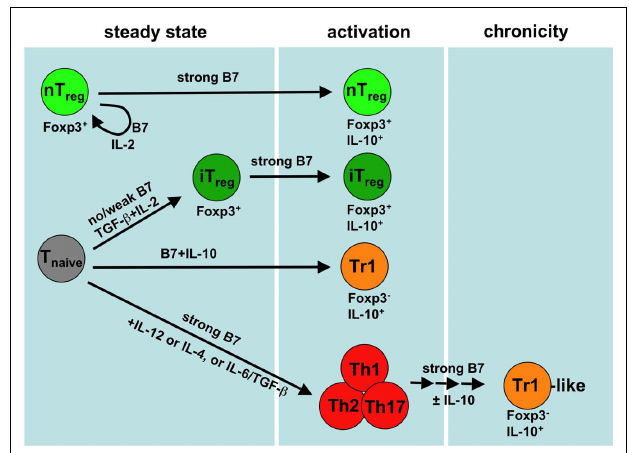
FIGURE 1 | Generation and maintenance of differentTreg subsets and their costimulation requirements. During the steady state thymus derived Foxp3 + nTregs require IL-2 and B7 (CD80/CD86) costimulation to persist.The conversion of iTregs from naiveT cells into the Foxp3 + subtype prefers the absence of B7 molecules but requires the presence ofTGF- β and IL-2. Strong B7 costimulation favors the activation of both Foxp3 + nTregs and Foxp3 + iTregs such as provided by mature DCs. Generation of Tr1 cells from naiveT cells requires the presence of costimulation and IL-10. The appearance ofTr1-like cells is preceded by immunogenicTh1 (by IL-12), Th2 (by IL-4), orTh17 (byTGF- β /IL-6) induction and subsequent short interval restimulations under the same immunogenic conditions that will result in a loss of theTh phenotype and a gain of IL-10 production capacity. Of note, all events indicated by arrows requireTCR signals in